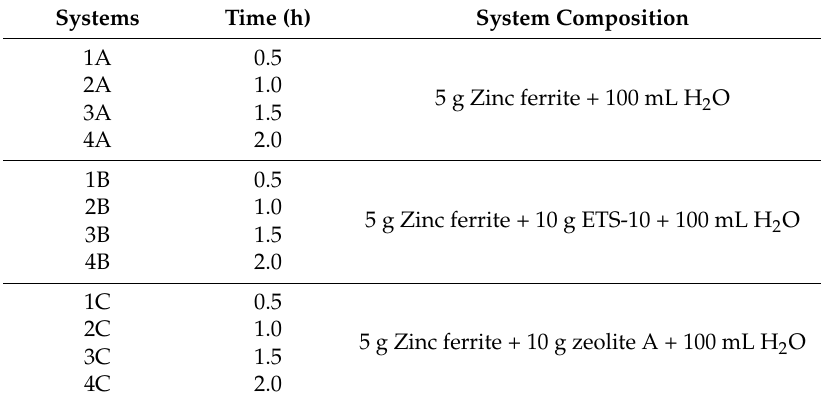
Table 1. Scheme of prepared systems for metal removal.